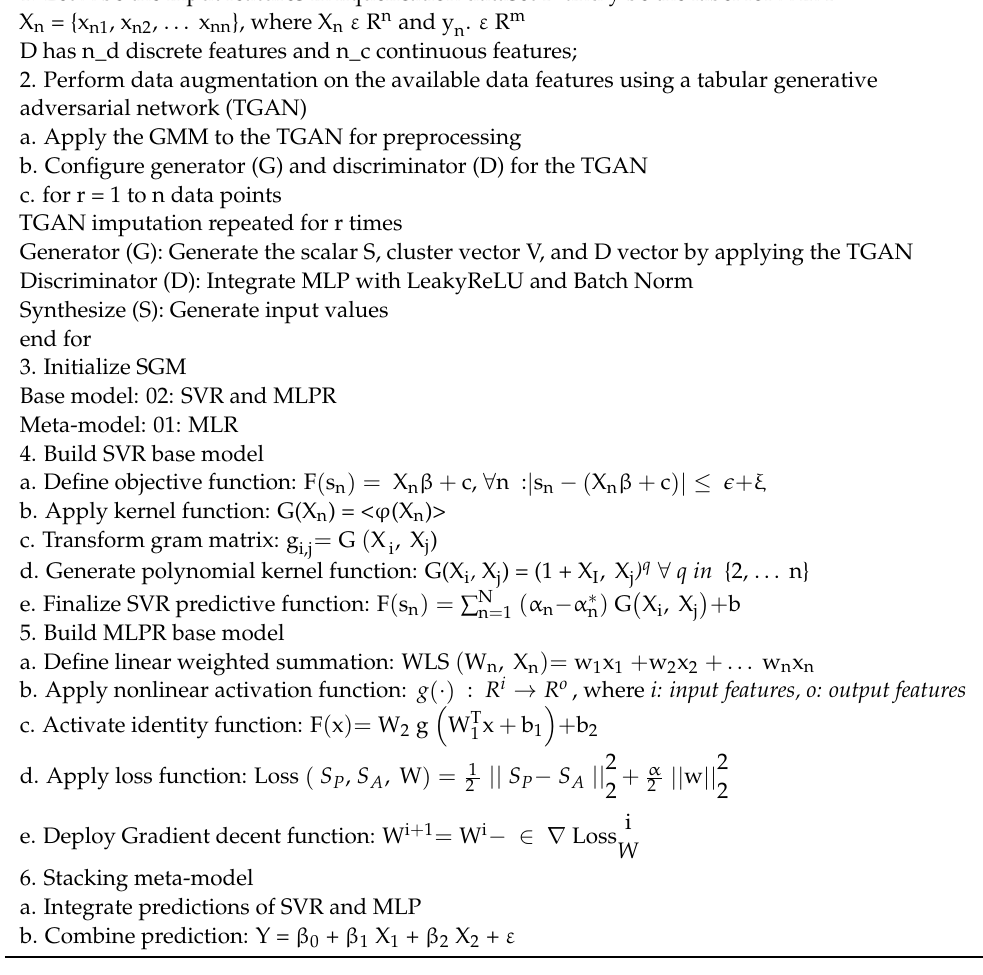
Algorithm 1: Stacked generalization model (SGM) for liquefication